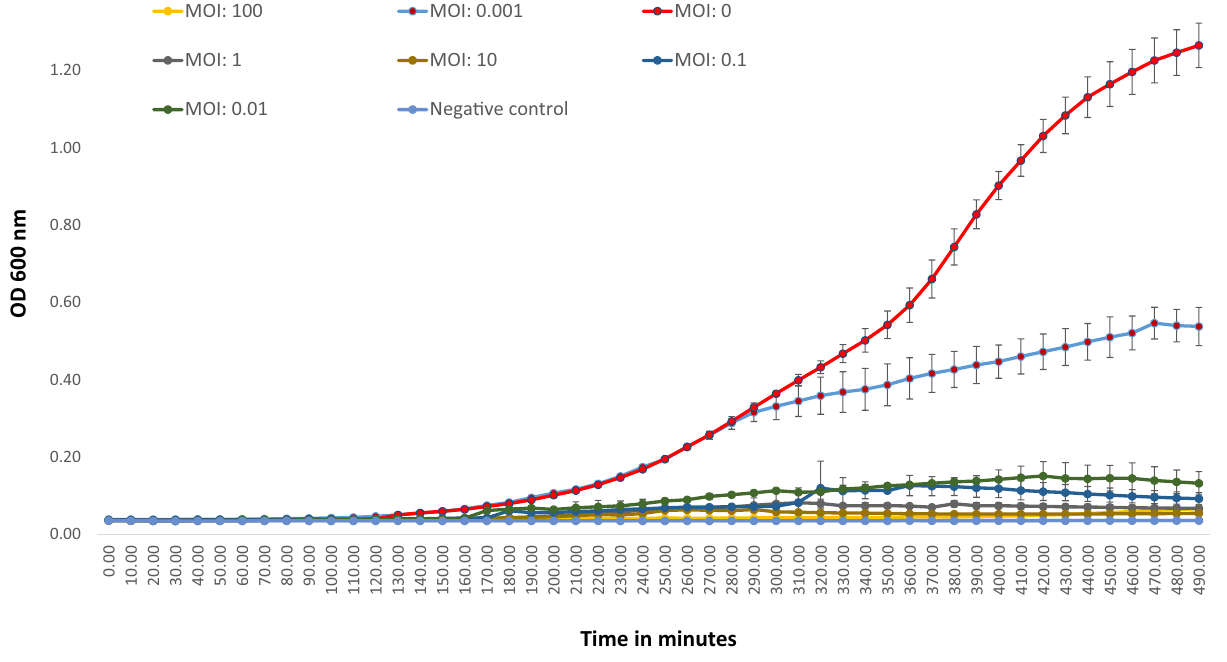
Figure 13. In vitro lytic activity of DRL-P1 against P. aeruginosa. Lytic activity was studied at Multiplicity of Infection (MOI), 100, 10, 1, 0.1, 0.01, 0.001 for 8 h. Bacterial growth was recorded by changes in absorbance (OD 600 ) using an automated multi-mode plate reader. Data displayed in the plot represent mean ± SD of three independent experiments. Plots were generated using the chart function incorporated in Excel program (MS Office version 18.2106.12410.0).